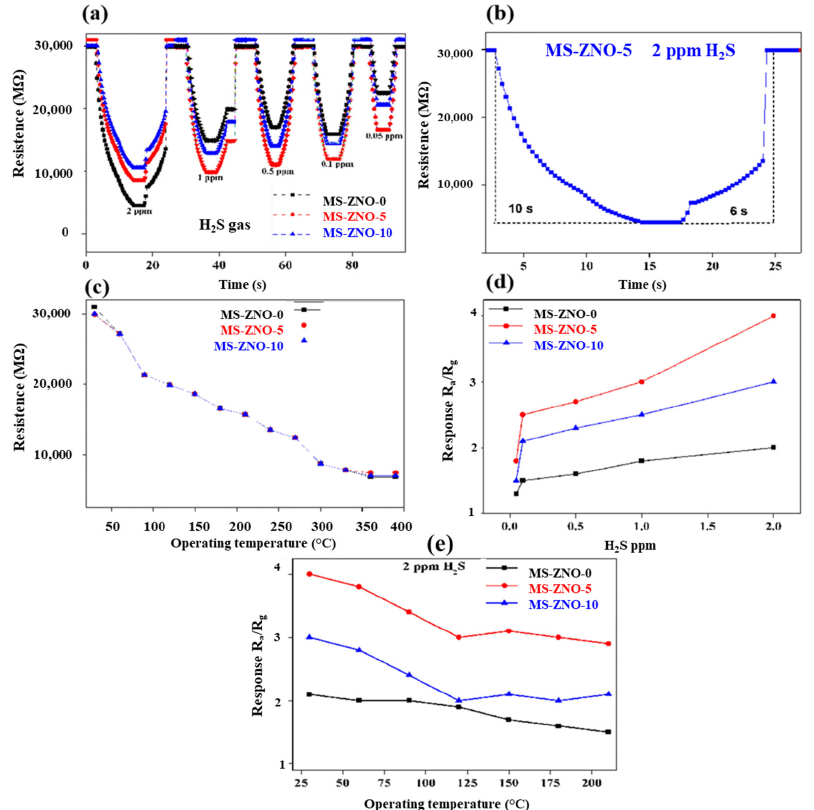
Figure 5. ( a ) Dynamic responses of all sensors to H 2 S 0.05-2 ppm at the operating temperature of 30 °C; ( b ) response/recovery diagram of MS-ZNO-5 towards 2 ppm H 2 S; ( c ) temperature resistance of pure and composite materials towards 2 ppm in the air at 30 °C; ( d ) graph of the relationship between the di ff erent concentration of H 2 S ppm and response at 30 °C; ( e ) the responses of all sensors towards 2 ppm H 2 S at various operating temperatures.